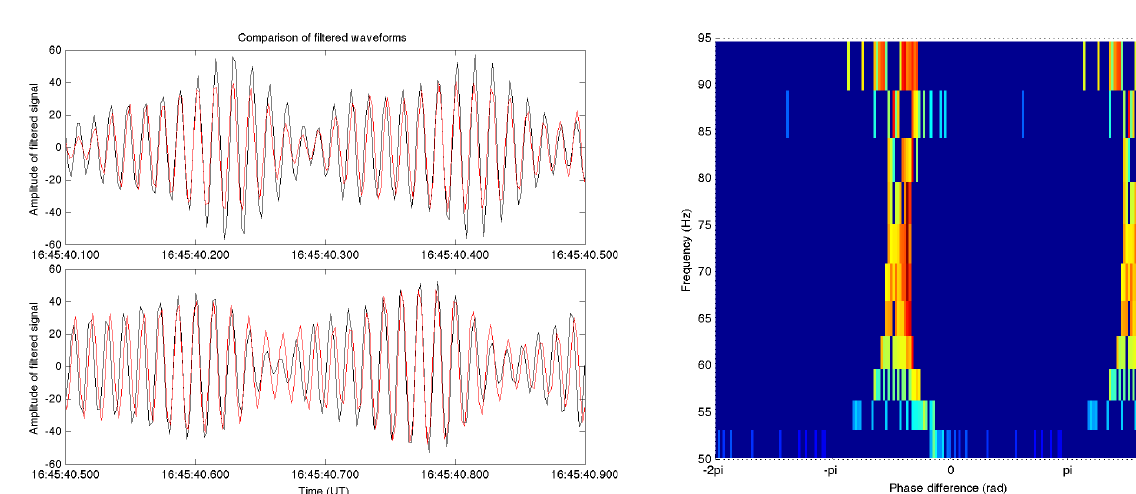
Fig. 4. A comparison of two wave packets measured by Cluster 1 and Cluster 2 with a time offset of 604ms.